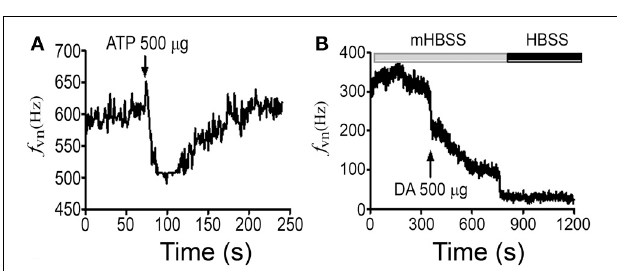
FIGURE 8 | Neuronal activation induced by mHBSS is sensitive to neurotransmitters. Representative recordings of electrical activity of rat NPJcs superfused with mHBSS and during steady state activity reached after application of 10 μ L of (A) 500 μ g ATP ( n = 5) or (B) 500 μ g dopamine (DA) ( n =